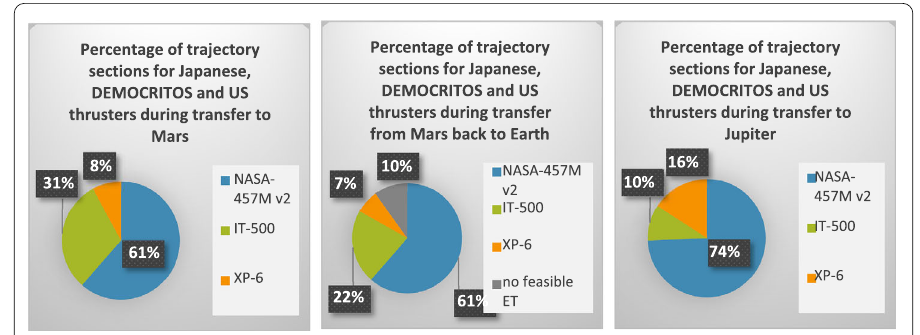
Figure 11 Percentages of trajectory sections for the cluster of Japanese, DEMOCRITOS and US thrusters